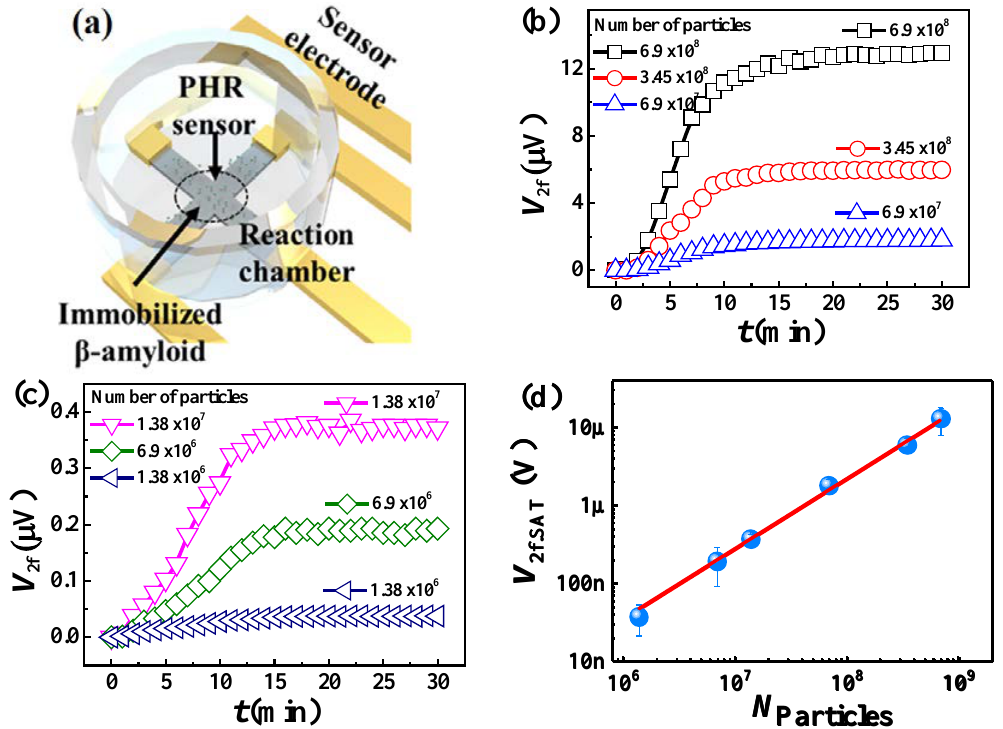
Figure 4. ( a ) Schematic representation of particle detection by PHR sensor. ( b ) Time dependences of the second harmonics PHR voltage V 2f measured at 3 different numbers of particles in a range from 6.9 × 10 8 to 6.9 × 10 7 . ( c ) Time dependences of the second harmonics PHR voltage V 2f , measured at 3 different numbers of particles in a range from 1.38 × 10 7 to 1.38 × 10 6 . ( d ) The linear dependence of the saturated value V 2f.SAT of the second harmonics voltage on the number of particles N Particles .